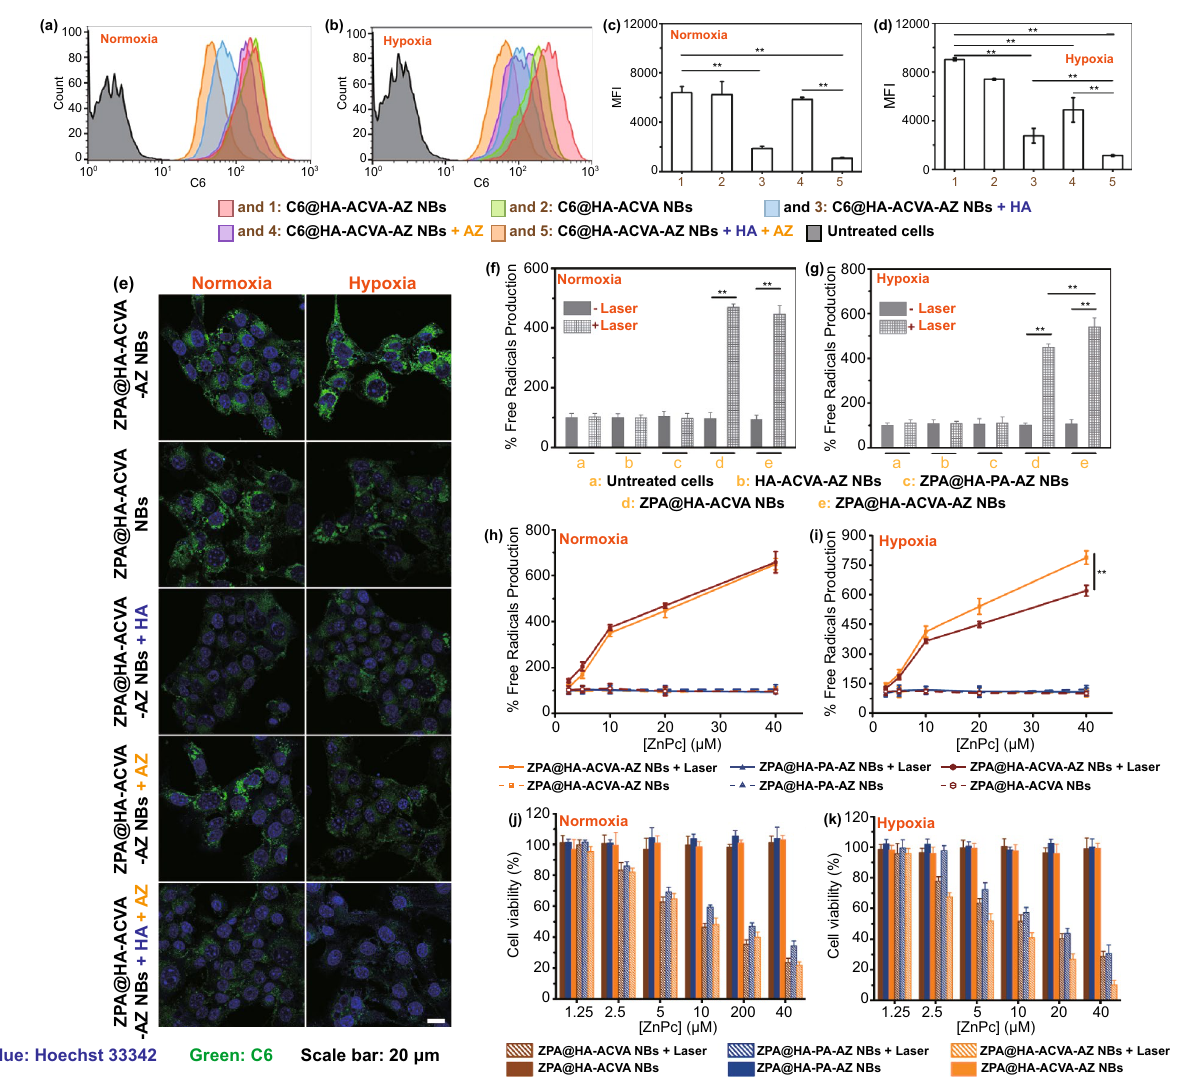
Fig. 3 In vitro cellular uptake, alkyl free radical generation and therapeutics of ZPA@HA-ACVA-AZ NBs. Comparison of a and c fluorescence intensity profile and b and d relative intracellular fluorescence intensity of 4T1 cells in normoxic and hypoxic conditions after being incubated with C6@HA-ACVA NBs and C6@HA-ACVA-AZ NBs with or without pre-treatment of HA ([HA] = 10 mg/mL) and AZ ([AZ] = 20 μM)) for 24 h as determined by flow cytometry. e Fluorescence images of C6@HA-ACVA NBs and C6@HA-ACVA-AZ NBs with or without pre- treatment of HA ([HA] = 10 mg/mL) and AZ ([AZ] = 20 μM)) after 24-h incubation. The cells were stained with Hoechst 33,342 to visualize the nuclei (blue) and the fluorescence of C6 was shown in the color of green. Alkyl radical production induced by different samples in 4T1 cells in f normoxic and g hypoxic conditions with or without laser irradiation. Alkyl radical production induced by different ZPA-loaded NBs in 4T1 cells at various ZnPc concentrations in h normoxic and i hypoxic conditions with or without laser irradiation. MTT assay for measure the inhibited proliferation efficacy on 4T1 cells treated with different ZPA-loaded NBs with or without laser irradiation in j normoxic and k hypoxic condi-